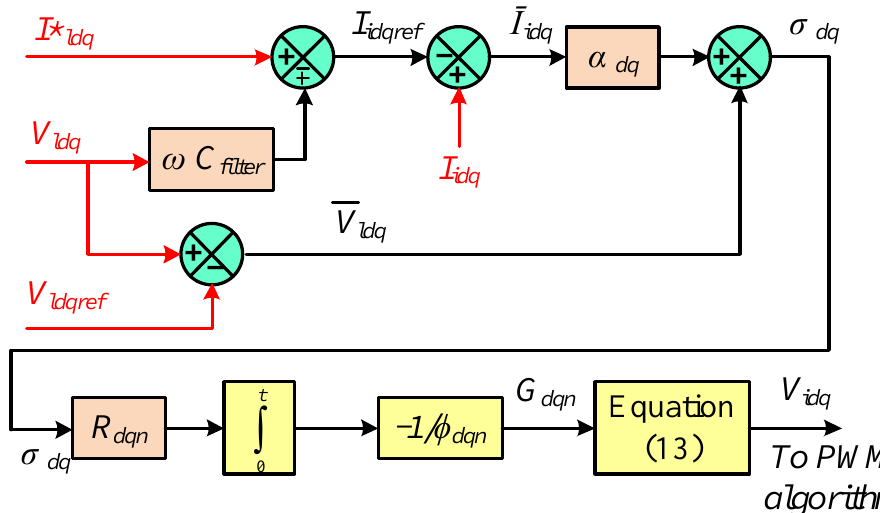
Figure 2. Block diagram for the implementation of adaptive voltage controller.